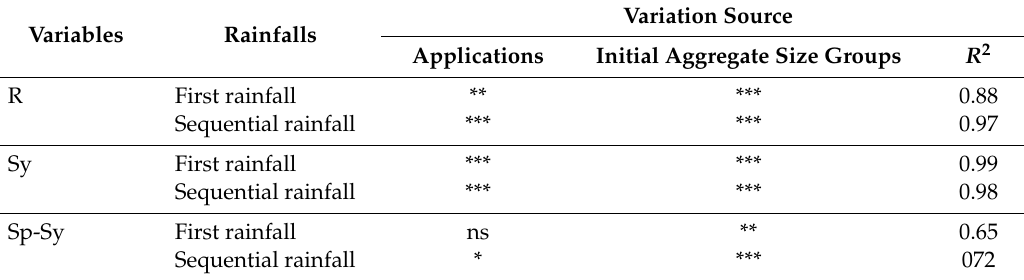
Table 4. ANOVA results of obtained data.